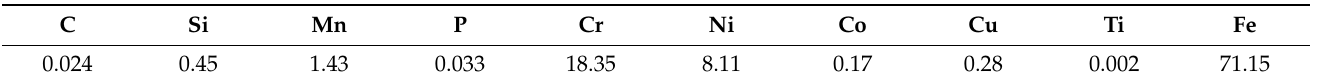
Table 1. Chemical composition of as-received Type 304L stainless steel containing δ -ferrite used in this work (in